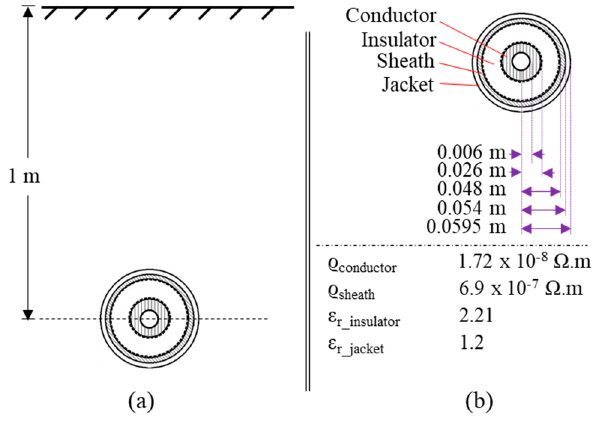
Figure 2. Underground cable section ( a ) layout ( b ) structure, dimensions & electrical properties.